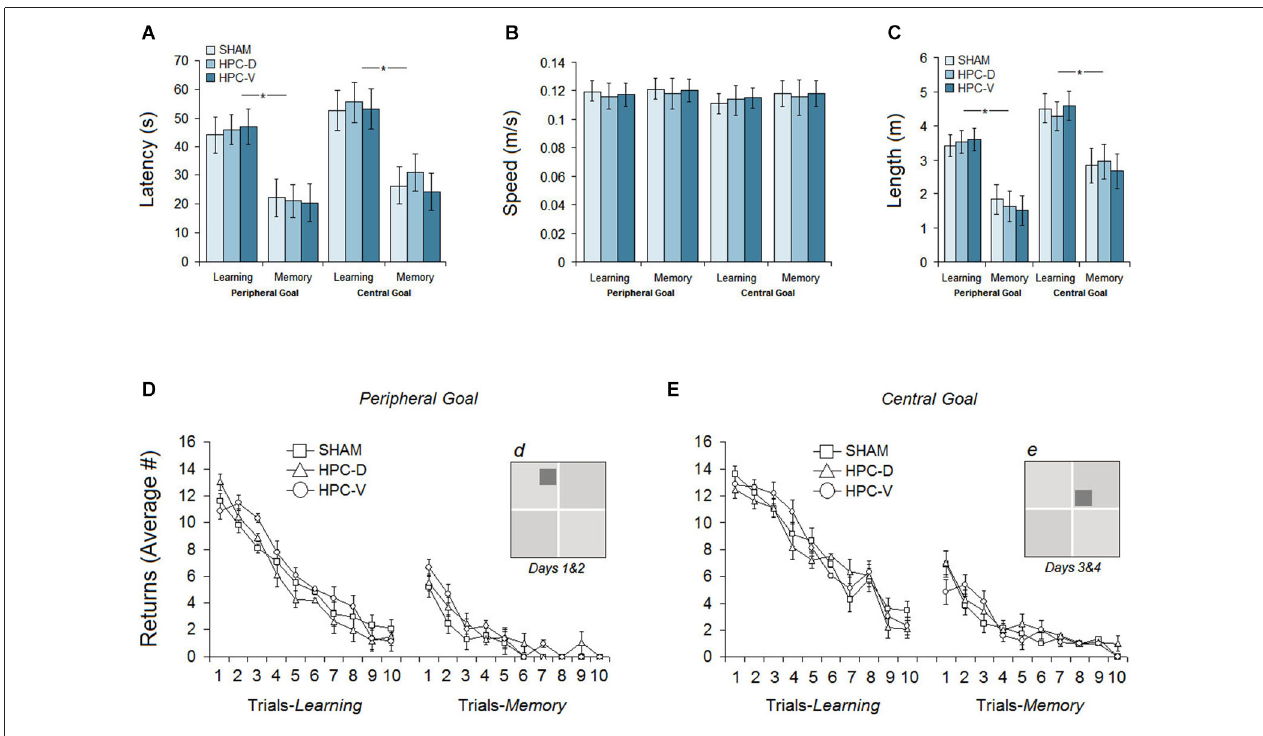
goal during each day of testing (learning and memory) on peripheral- and central-goal trials. ( D and E ) The number of returns for three groups on learning and memory days during spatial navigation in the ZT to locate peripheral and central goal ziggurats. (d and e) Dark gray squares indicate the location of peripheral and central spatial goals,